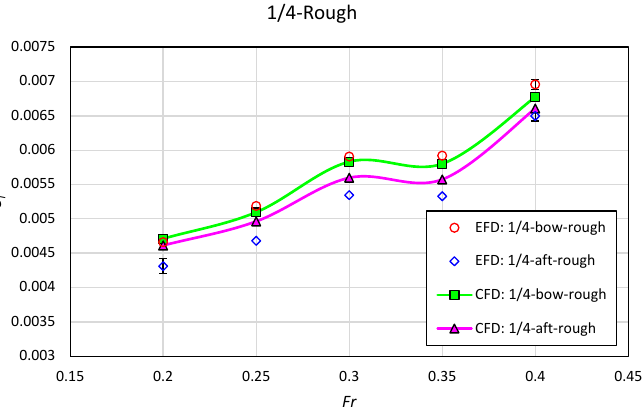
Figure 7. 𝐶 (cid:3021) of the Wigley hull with smooth and full-rough conditions obtained from the current Computational Fluid Dynamics (CFD) simulations and the Experimental Fluid Dynamics (EFD) result [27]. Figure 8; Figure 9 show the 𝐶 (cid:3021) values of the Wigley hull with the heterogeneous hull roughness conditions (i.e., ¼-bow-rough, ¼-aft-rough, ½-bow-rough and ½-aft- rough). As observed from the physical towing tests of Song et al. [27], the current CFD simulations predicted larger 𝐶 (cid:3021) values for the bow-rough conditions (¼-bow-rough and ½-bow-rough) than the aft-rough conditions (¼-aft-rough and ½-aft-rough). The percent- age differences between the CFD and EFD results can be found from Table A1 in Appen- dix A.